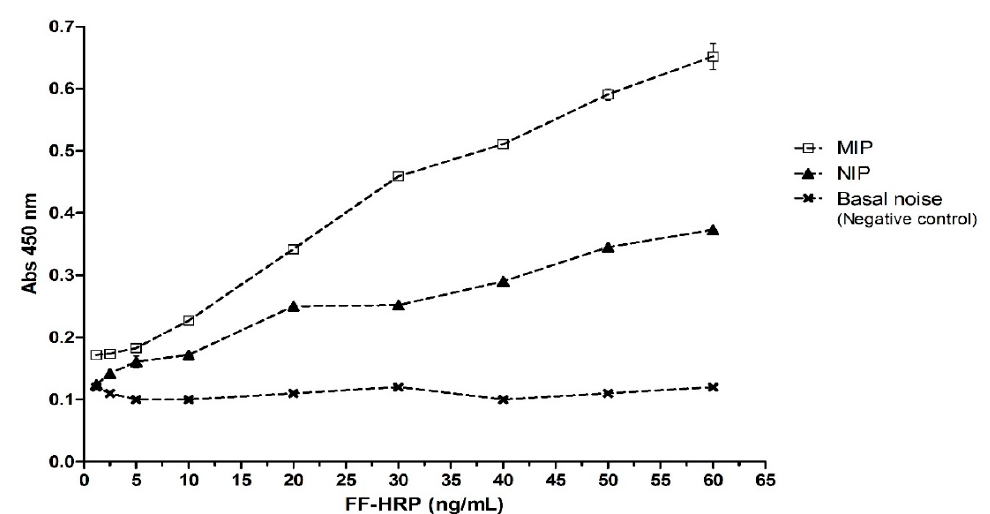
Figure 3. Detection of FF on ELISA microplates with immobilization of nanoMIPs.